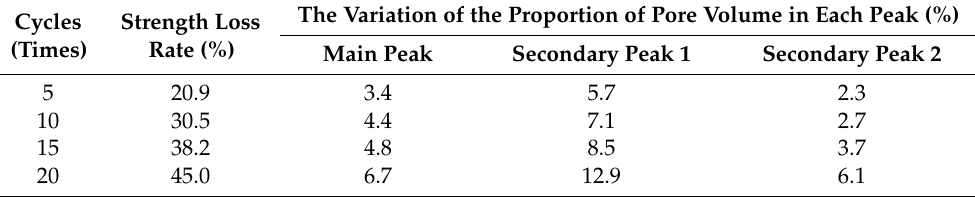
Table 7. Changes in the ratio of pore volume to each peak in coarse-grained soil T-2 curve.